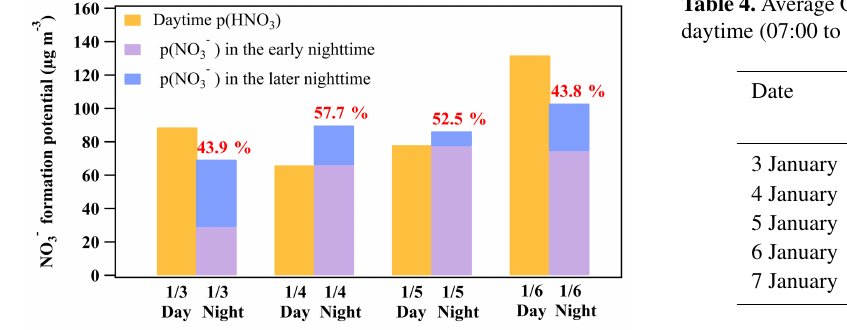
Table 4. Average OH mixing ratio and rate of OH + NO 2 during